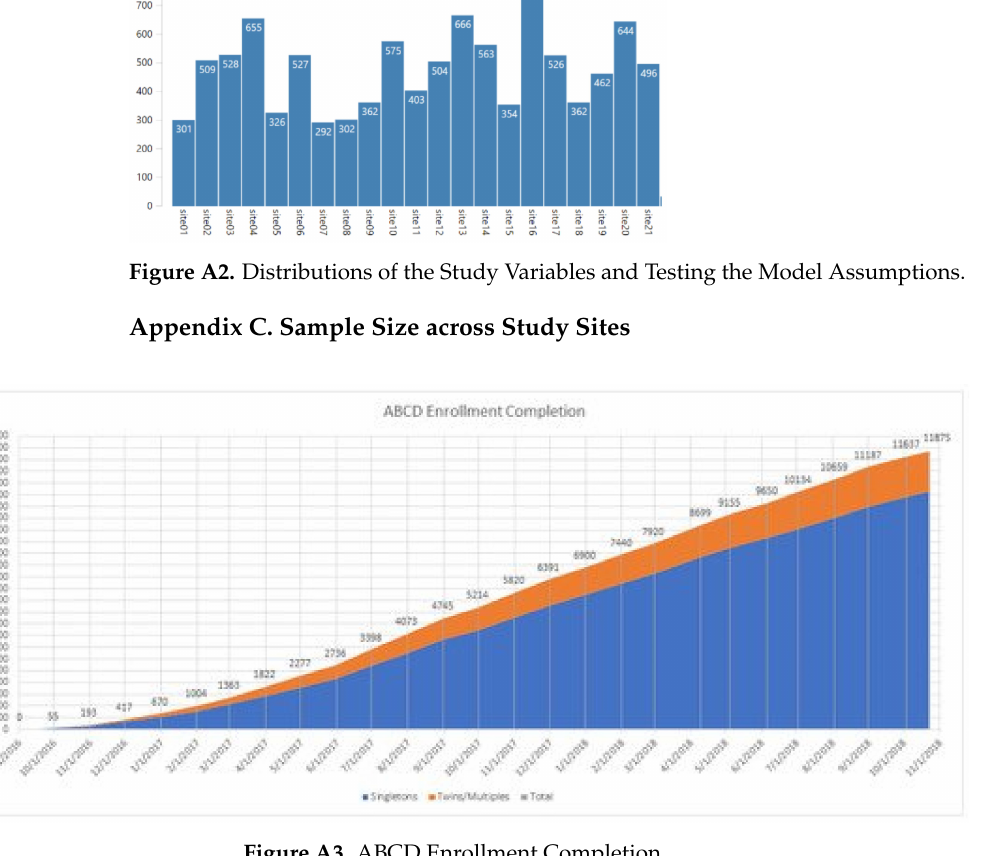
Figure A3. ABCD Enrollment Completion.